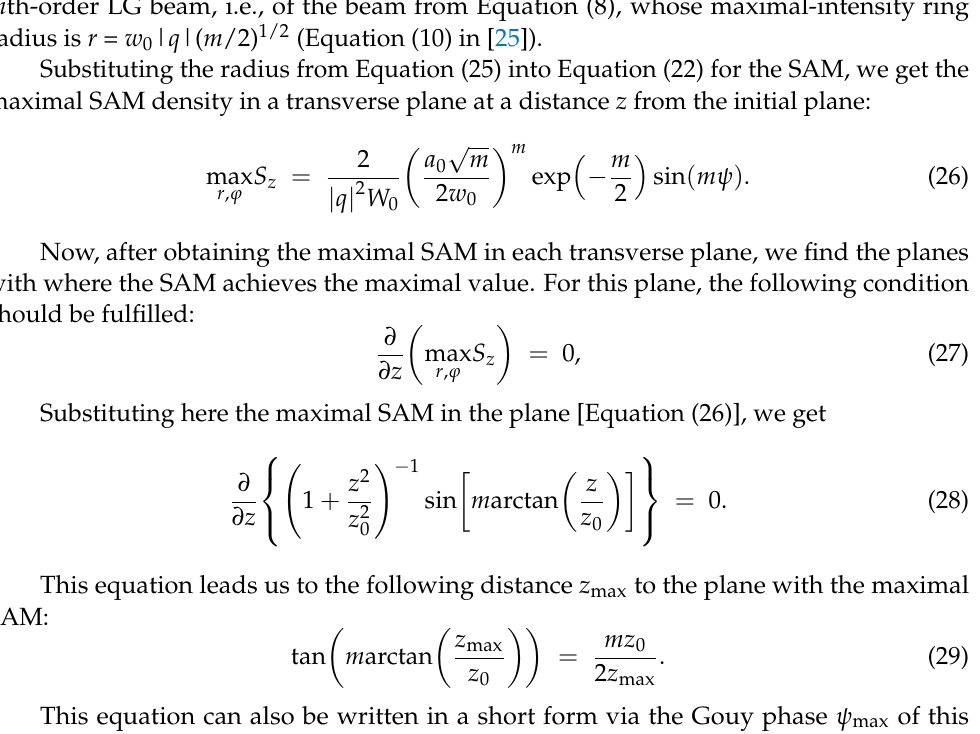
√ This radius is 2 times smaller than the radius of maximal intensity of a single-ringed m th-order LG beam, i.e., of the beam from Equation (8), whose maximal-intensity ring radius is r = w 0 | q |( m /2) 1/2 (Equation (10) in [25]). Substituting the radius from Equation (25) into Equation (22) for the SAM, we get the maximal SAM density in a transverse plane at a distance z from the initial